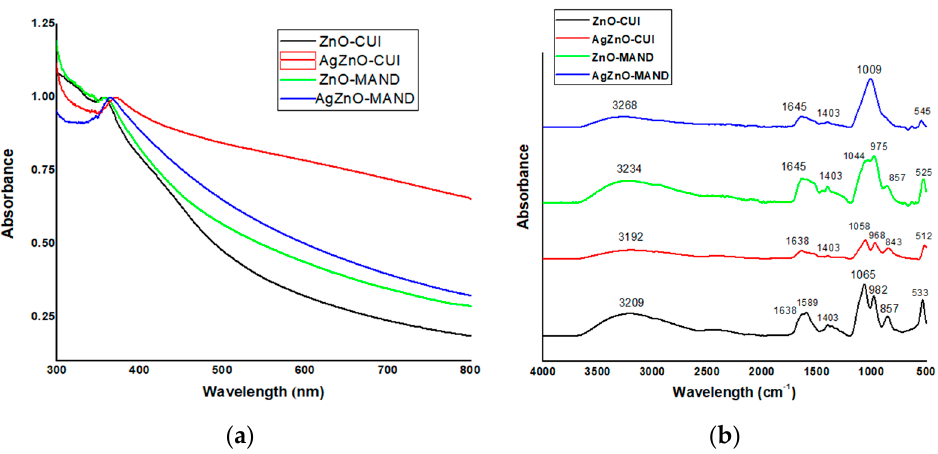
Figure 5. Optical characterization of “green” developed materials: ( a ) UV-Vis absorption spectra (normalized at the ZnO corresponding UV absorption peak) and ( b ) FTIR spectra of the phytosynthesized materials.